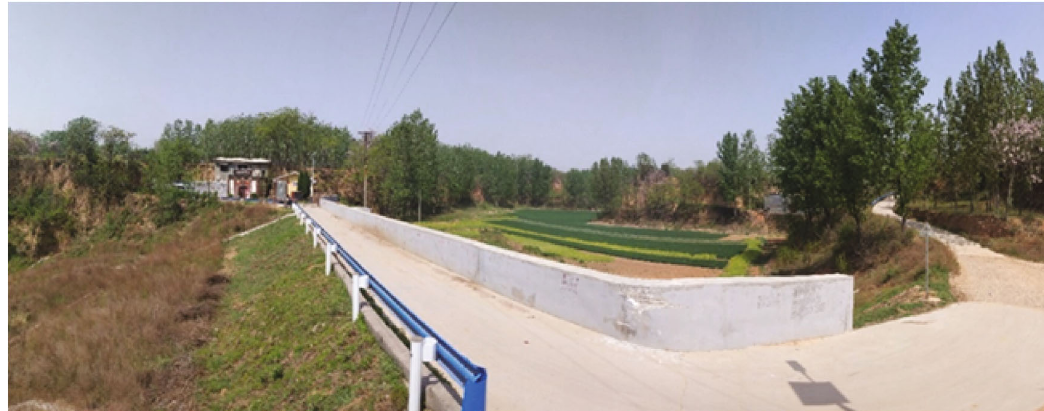
Figure 2: The panorama of